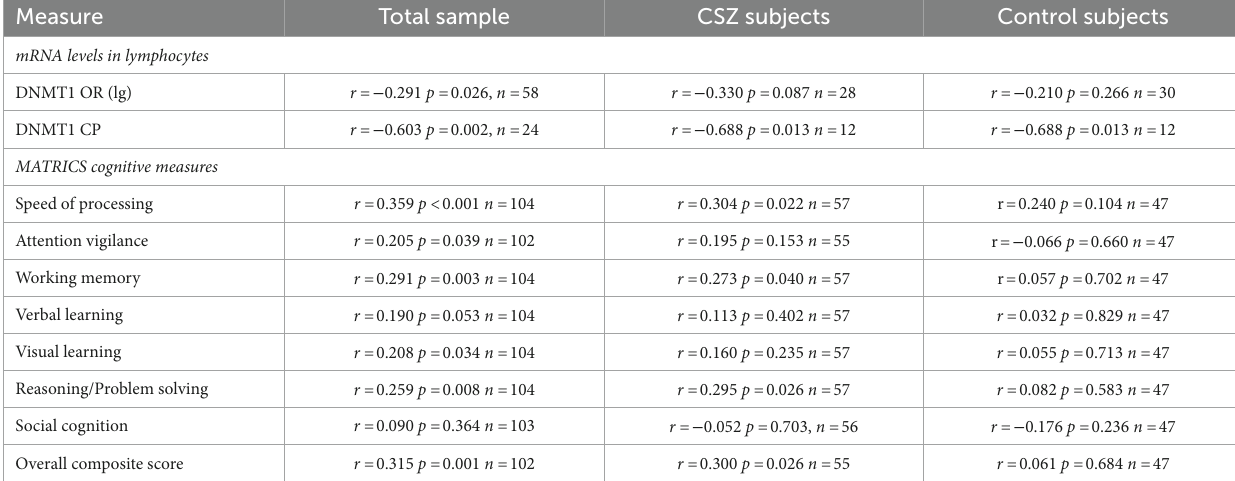
TABLE 4 Correlations between odor identification scores and mRNA and cognitive measures. Measure